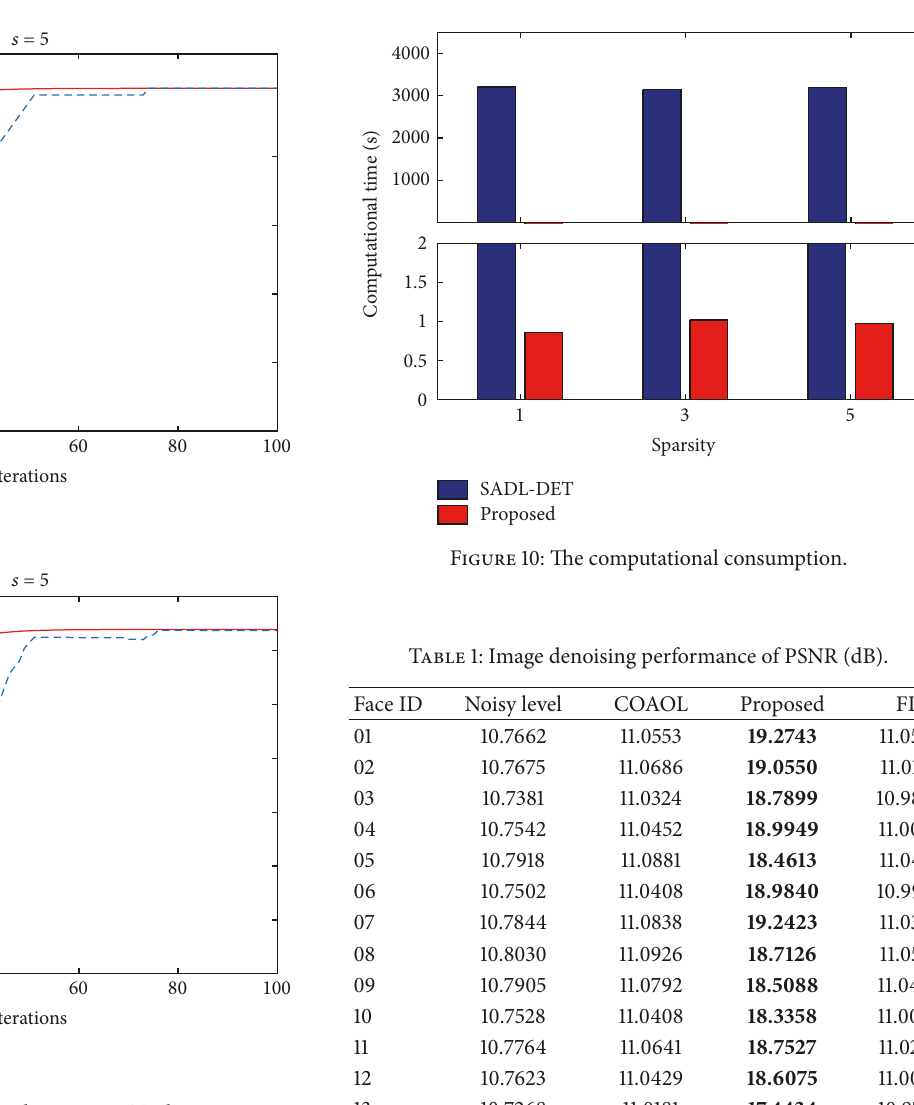
Figure 9: The comparison with SADL-DET when 𝑠 = 5 .